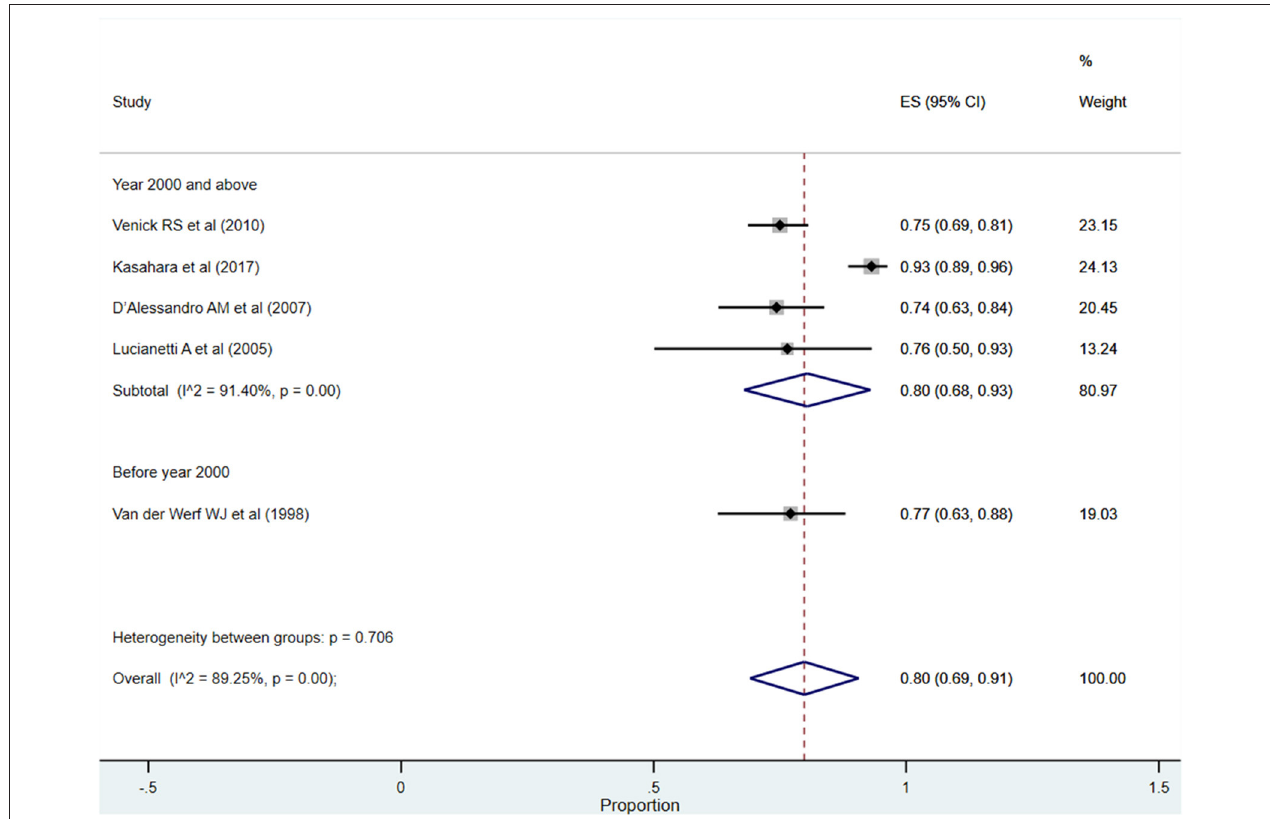
FIGURE 4 | Pooled patient survival rate among infants at more than 5 years post-liver transplantation.